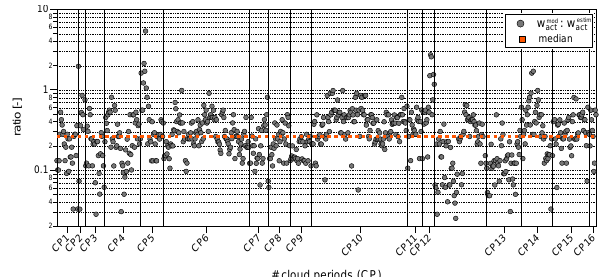
Figure 4. Ratio of the simulated updraft velocity ( w mod act ) and the es- timated updraft velocity at the cloud base ( w estim act ) for each model simulation categorized for the different cloud periods (CP). The lines and the labels of CP serve to identify different cloud periods between which there are gaps of non-cloudy time. The orange line indicates the median ratio of w mod act : w estim act